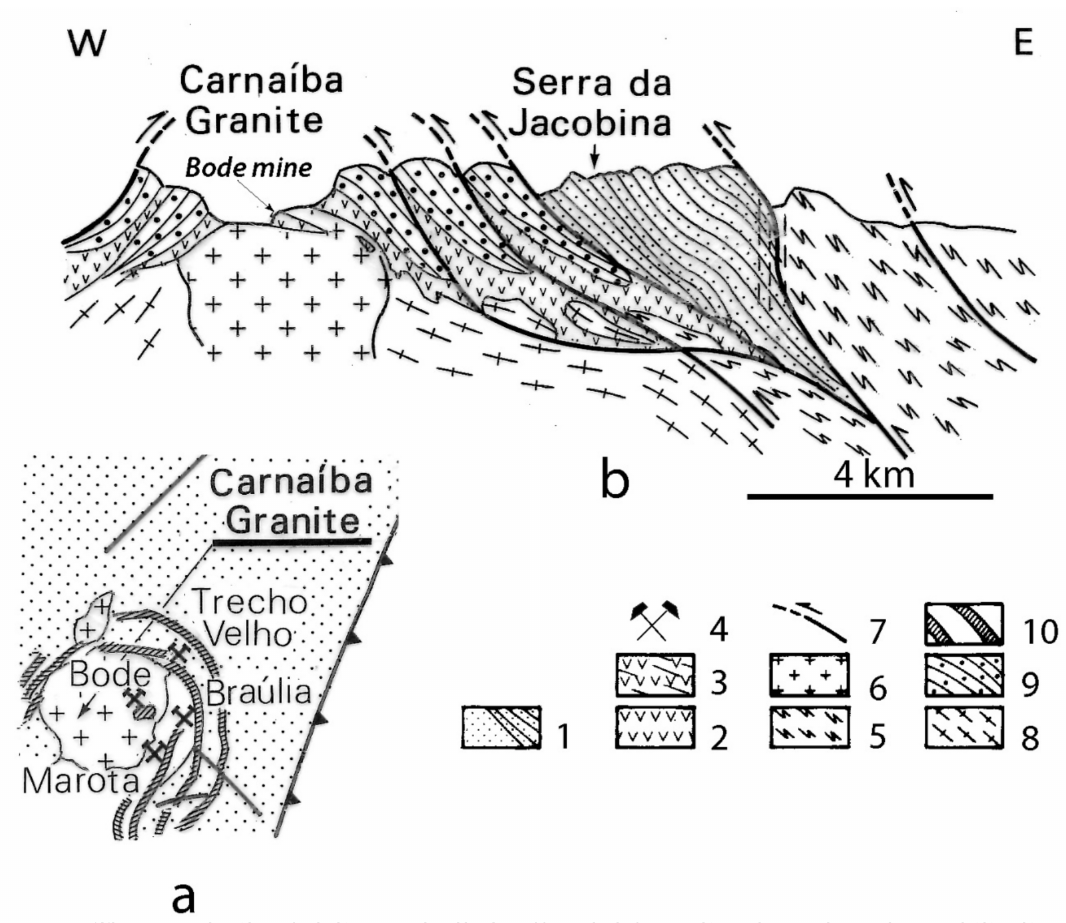
Figure 36. Schematic geological section of the emerald deposits of Carna í ba, Bahia state, Brazil: ( a ) The granite of Carna í ba and its emerald deposits cited in the present work. The Bode deposit is located in a roof-pendant of serpentinite present at the roof of the granite; ( b ) The Serra da Jacobina volcano-sedimentary sequence formed by intercalations of quartzite and serpentinite is crosscut by the Carna í ba granite. The pendants of serpentinite are present at the contact and on the roof of the granitic intrusion.